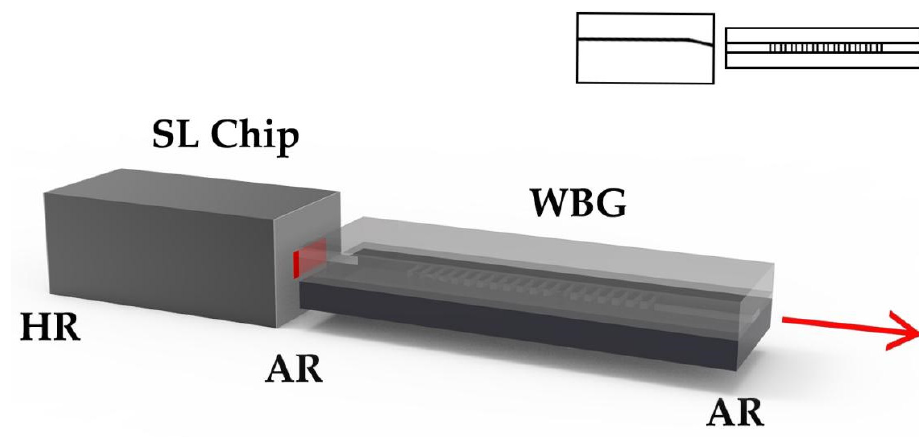
Figure 9. Structure of WBG-ECSL.